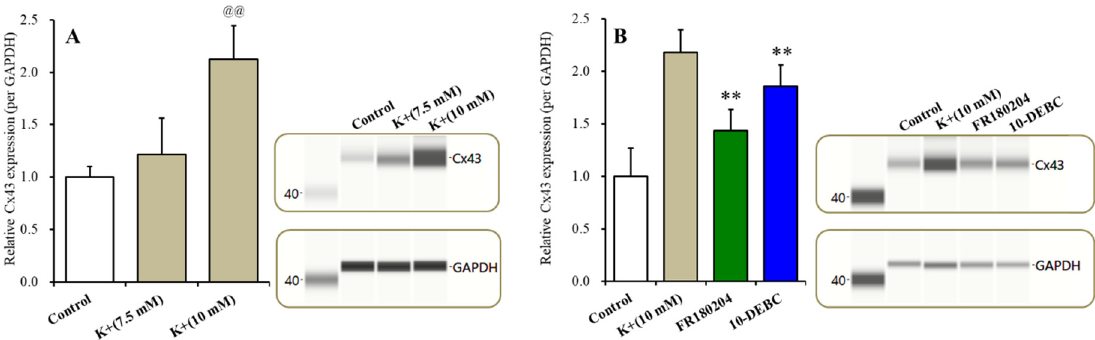
Figure 7. E ff ects of subacute administration of an increase in the extracellular K + level on Cx43 expression in the plasma membrane fraction of primary cultured astrocytes ( A ). E ff ects of the inhibitor of Erk (FR180204) and Akt (10-DEBC) on K + -dependent Cx43 expression in the plasma membrane ( B ). Ordinate: mean ± SD ( n = 6) of the relative protein level of Cx43. Concentration-dependent e ff ects of extracellular K + on Cx43 expression in the plasma membrane fraction of the primary cultured astrocytes were analyzed by a one-way ANOVA (@@ p < 0.01 vs. control). The e ff ects of 20 µ M FR180204 and 10 µ M 10-DEBC on Cx43 expression in the plasma membrane fraction were analyzed by a Student’s t -test (** p < 0.01 vs. 10 mM K + ).